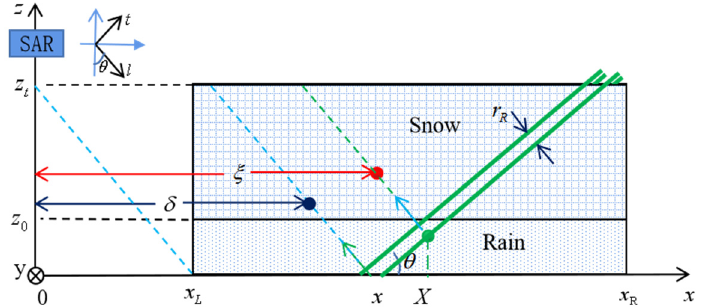
Figure 1. Simplified cross sectional model of precipitation. The x -axis is the cross-track direction, the y -axis is the along-track direction, the z -axis is the altitude direction, the l -direction is the propagation direction of microwaves emitted by the radar, and the t -direction is the direction of the reflected microwaves, perpendicular to the l -direction. z t is the height of the rain-cloud cell in km and z 0 is the boundary height of the rainfall and snowfall in km. θ is the slant off-nadir angle. The microwave pulses emitted by the radar are considered as plane wave front slices, shown as a pair of lines with a width of r R . δ is the x -coordinate of the point on the path of the backscattering echo caused by ground. ξ is the x -coordinate of the point on the path of the backscattering echo caused by hydrometeors. X is the 𝑥 -coordinate of the point on the microwave front slices. Rectan- gular rain-cloud cell is chosen just for simplicity and more shapes will be used in the simulation section.